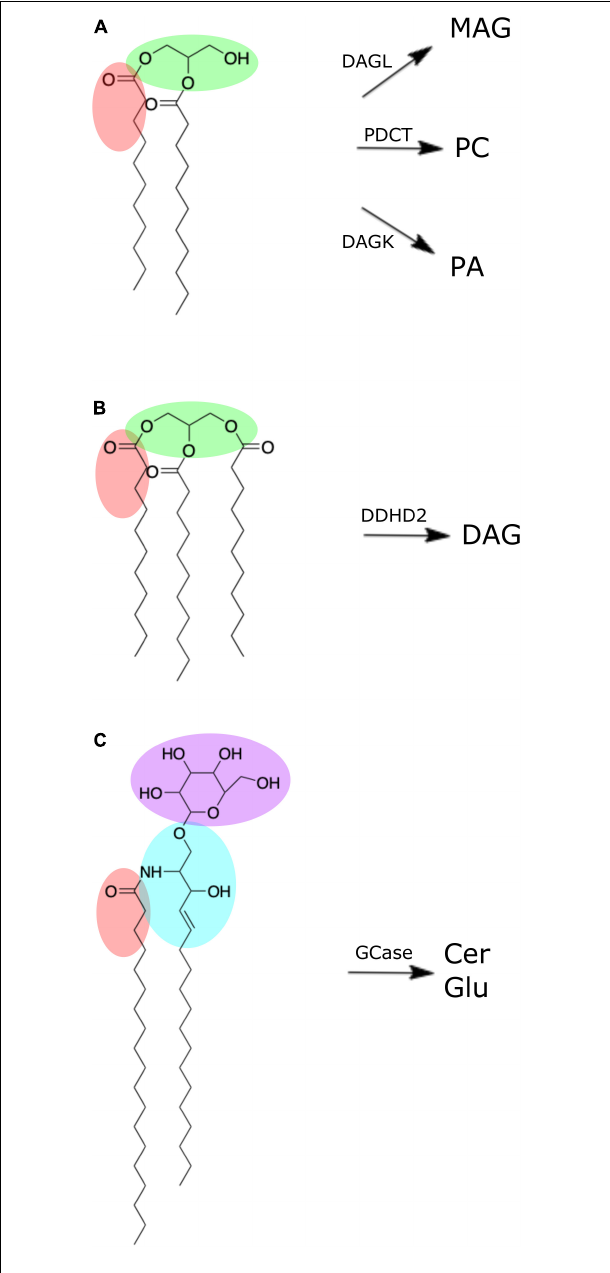
FIGURE 2 | Chemical structures of brain lipid molecules (created using ChemDraw Direct, Version 19.0.0). (A) Diacylglycerol is composed of a glycerol molecule (green) bonded to two fatty acid chains (one of which is highlighted red). Diacylglycerol can be metabolized by diacylglycerol lipase (DAGL) to form monoacylglycerol (MAG), phosphatidylcholine diacylglycerol phosphotransferase (PDCT) to form phosphatidylcholine, or diacylglycerol kinase (DAGK) to form phosphatidic acid. (B) Triacylglycerol is composed of a glycerol molecule (green) bonded to three fatty acid chains (one of which is highlighted red). Triacylglycerol can be metabolized by DDHD domain containing 2 (DDHD2) to form diacylglycerol. (C) Hexosyl ceramide is composed of a ceramide with sphingosine backbone (blue) and fatty acid (red) bonded to either a glucosyl or galactosyl group. If it is a glucosyl group (purple) it forms glucosylceramide, which can be metabolized by β -glucocerebrosidase (GCase) to form ceramide (Cer) and glucose